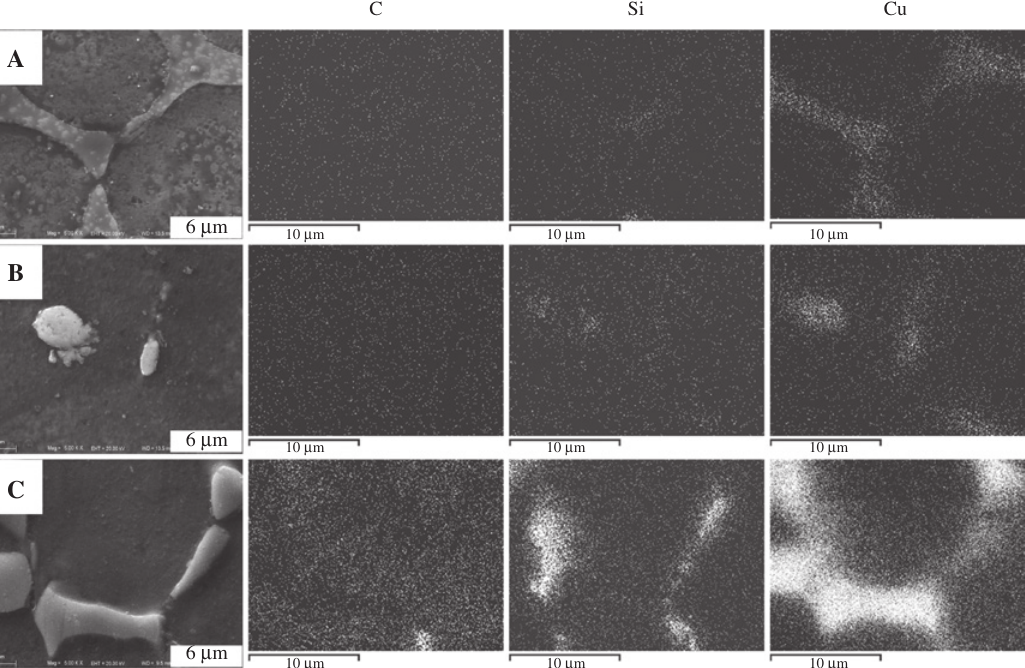
/Al2014 composites with different particle contents: p